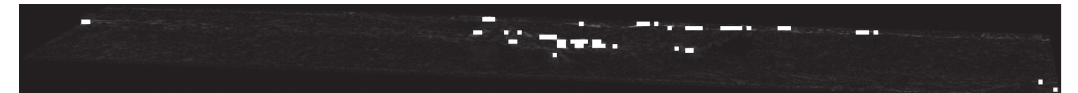
Figure 8: Blocs decomposition, classification, and thresholding. The white blocs represent areas with significant movement that may correspond to a swimmer. Swimming Championships in Limoges, France, April 2015.